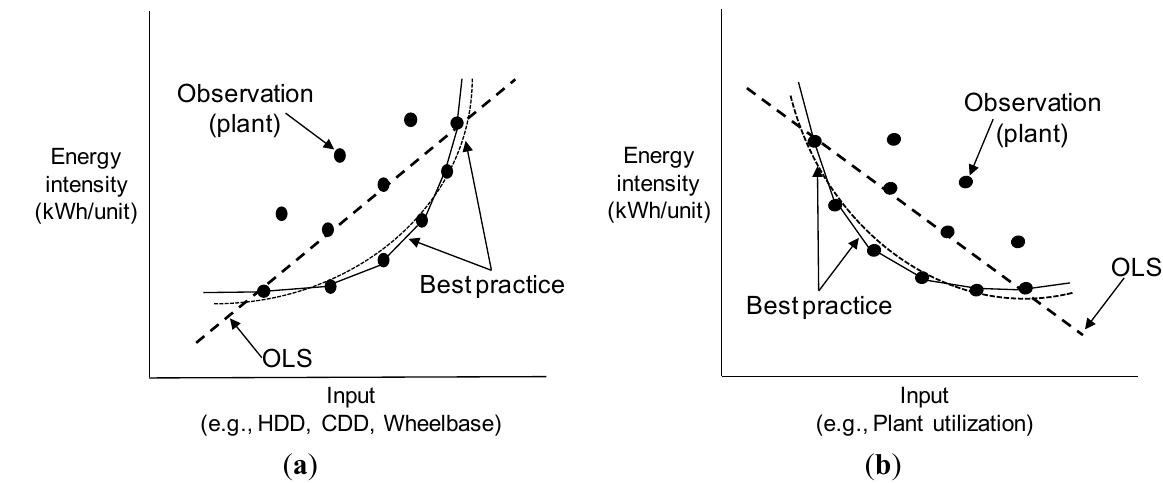
Figure 4. Various relationships between energy intensity and non-energy factors (based on a cross-sectional data set). ( a ) Concave-up increasing energy intensity; ( b ) Concave-up decreasing energy